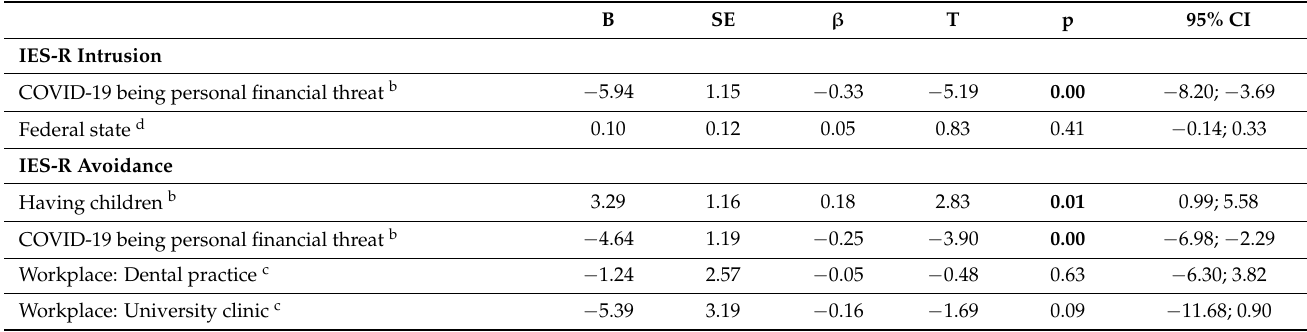
Table 7. Multiple regression studies of IES-R scores with pertinent